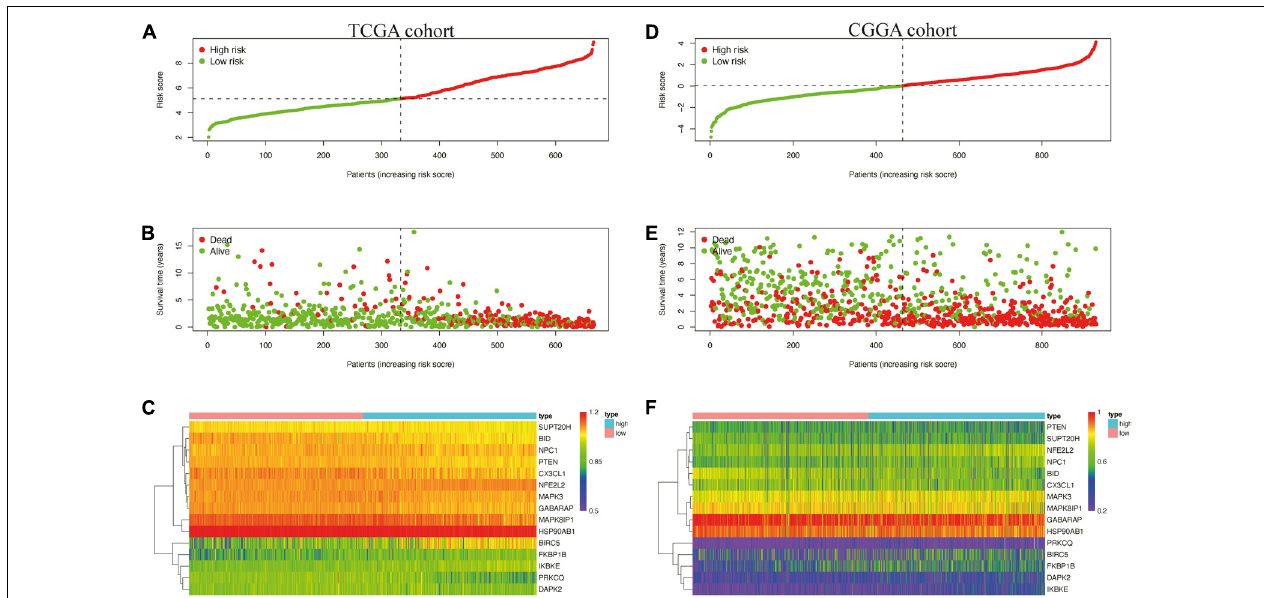
FIGURE 5 | Distribution of the risk score (A,D) survival status (B,E) and expression level of risk genes (C,F) in the Cancer Genome Atlas (TCGA) and the Chinese Glioma Genome Atlas (CGGA)